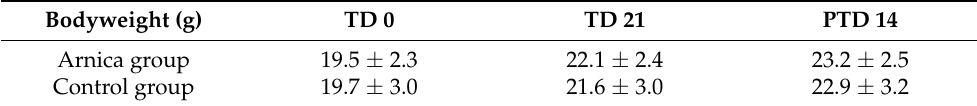
Table 4. Bodyweight development in the Arnica group ( n = 10) and the control group ( n = 6). Bodyweight (g)